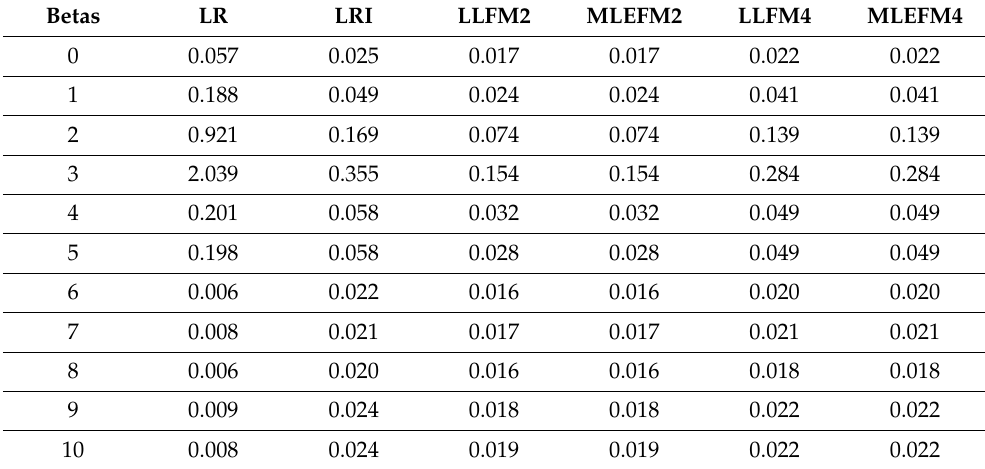
Table 4. Mean squared error of predictor coefficient estimates over 200 repetitions for N = 1000 for the logistic regression and factorisation machine models.